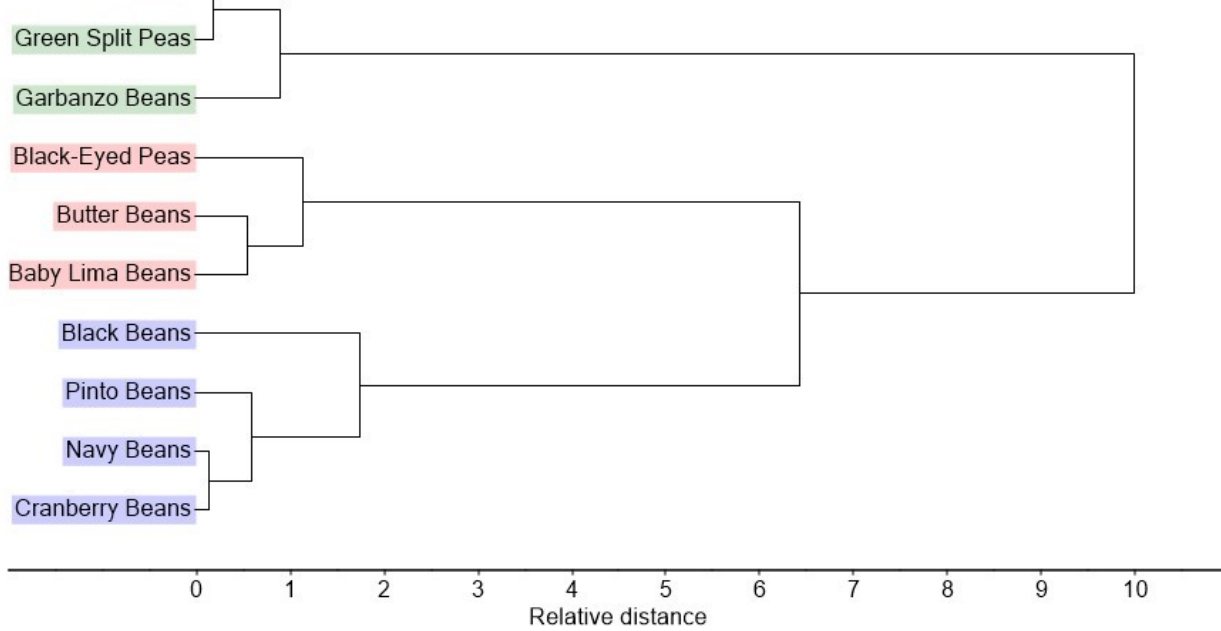
Figure 4. Hierarchical Cluster Analysis dendrogram showing clusters based on the complete FA compositions by C:U of the ten pulse samples. Colors match ovals in Figure 2. compositions by C:U of the ten pulse samples. Colors match ovals in Figure